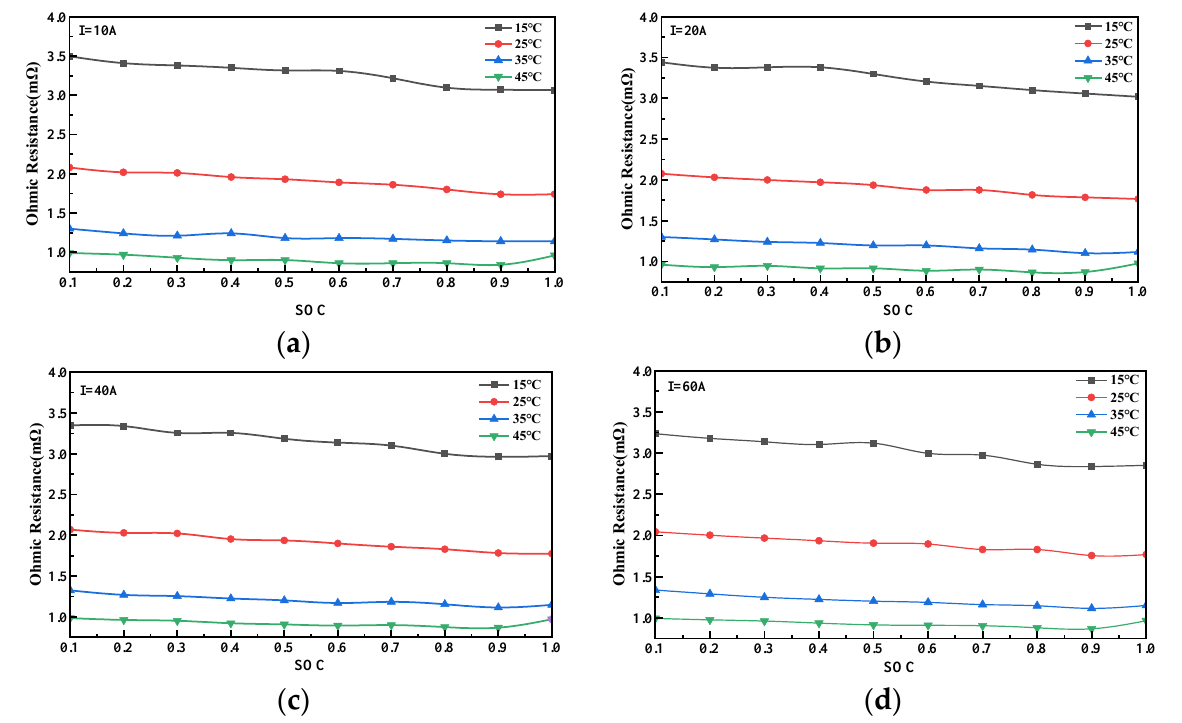
Figure 4. Identification of Ohmic resistance ( R 0 ) of battery: ( a ) The current of 10A, ( b ) the current of 20A, ( c ) the current of 40A, and ( d ) the current of 60A.